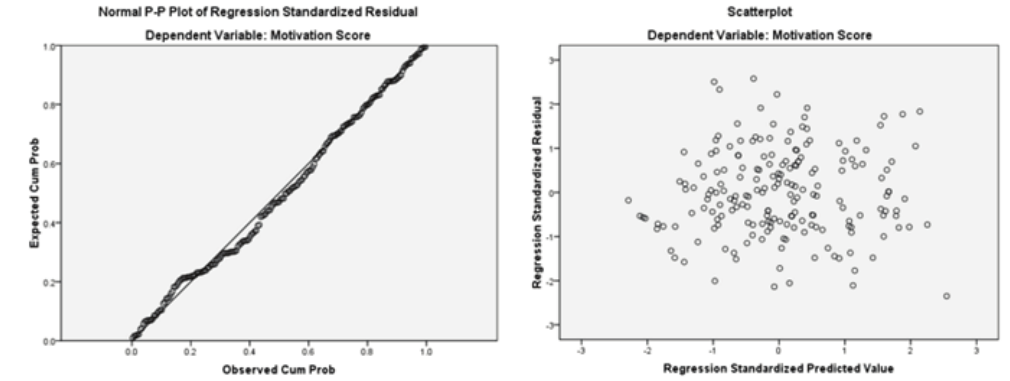
Figure 2: Normal probability plot (P-P) of the regression standardized residuals (left) and the scatter plot (right).